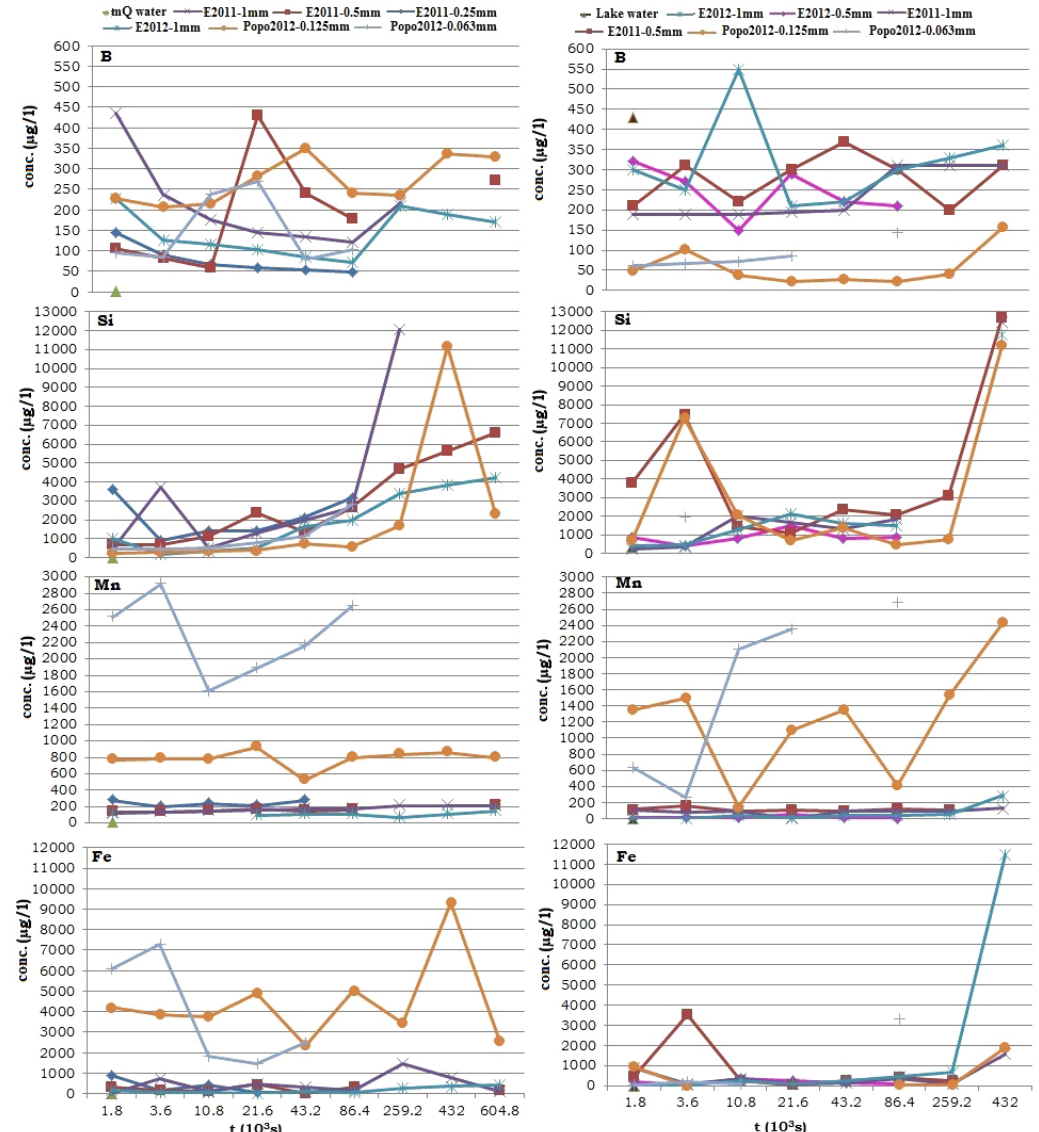
Figure 9. Trace elements’ (B − , Si 2 + , Mn 2 + , and Fe) variation of ash leachates in mQ (left column) and in lake water (right column) for variable stirring times and different grain sizes. The different trace elements’ contents of mQ and lake water are reported for